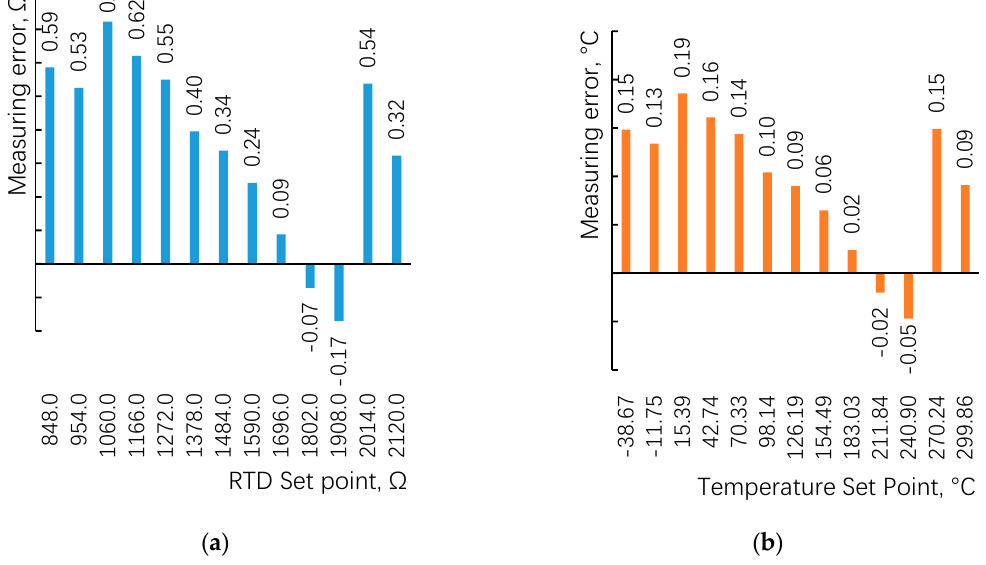
Figure 5. ( a ) Measurement errors of resistance when lead wire resistance is 1 Ω ; ( b ) Measurement errors of corresponding temperature when lead wire resistance is 1 Ω .